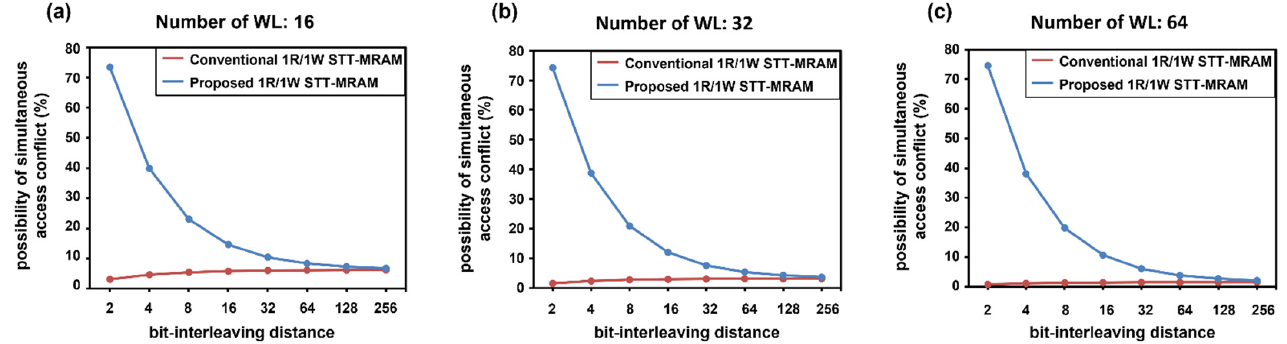
Figure 7. Probability of simultaneous access conflict with respect to the bit-interleaving distance when the number of WLs per bank is ( a ) 16, ( b ) 32, and ( c ) 64, respectively.